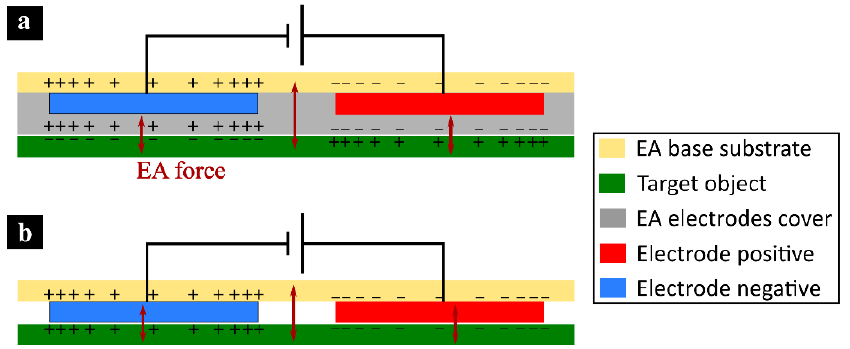
Figure 1. ( a ) Schematic diagram showing a typical electroadhesion (EA) system with encapsulated electrodes and ( b ) exposed electrodes.